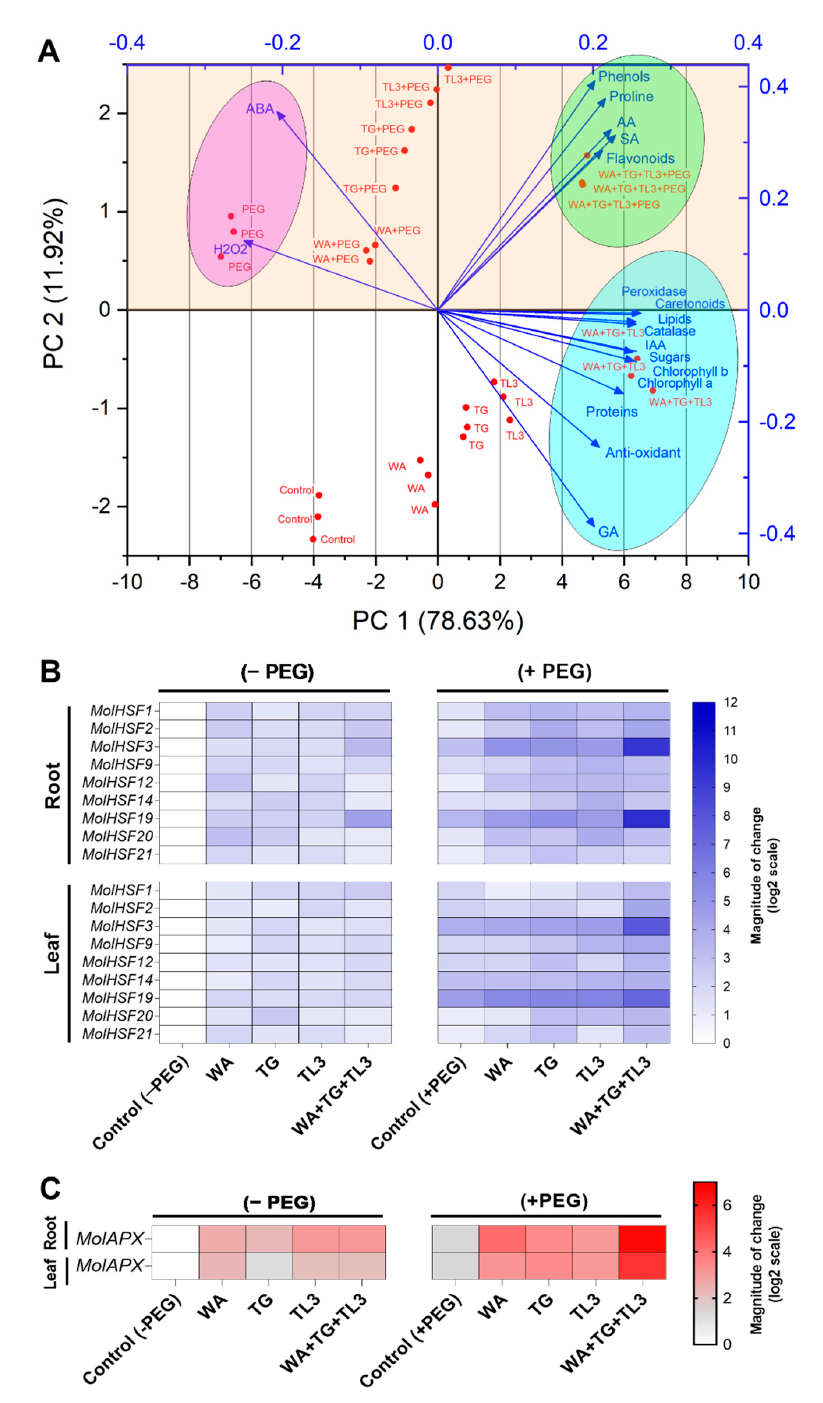
Figure 9. ( A ) Principal component loading plot and scores of principal component analysis (PCA) of physiochemical parameters, chlorophyll b, chlorophyll a, carotenoids, proteins, phenols, sugars, flavonoids, lipids, proline, IAA, GA, SA, AA, peroxidase, anti-oxidant, catalase, ABA and H 2 O 2 of M. oleifera as affected by PEG-mediated drought stress under different endophytic treatments: WA, TG, and TL3 alone or in combination (WA, TG, and TL3) compared with the non-inoculated respective controls (0% PEG and 8% PEG). The scores show the contribution of individual treatments on plant traits, as indicated by the direction and magnitude of the eigenvector vectors, ( B ) expression profiling of HSF genes, and ( C ) APX gene measure by RT-qPCR. Quantitative data represent the means ± SD of three independent experiments and at least three technical replicates each.